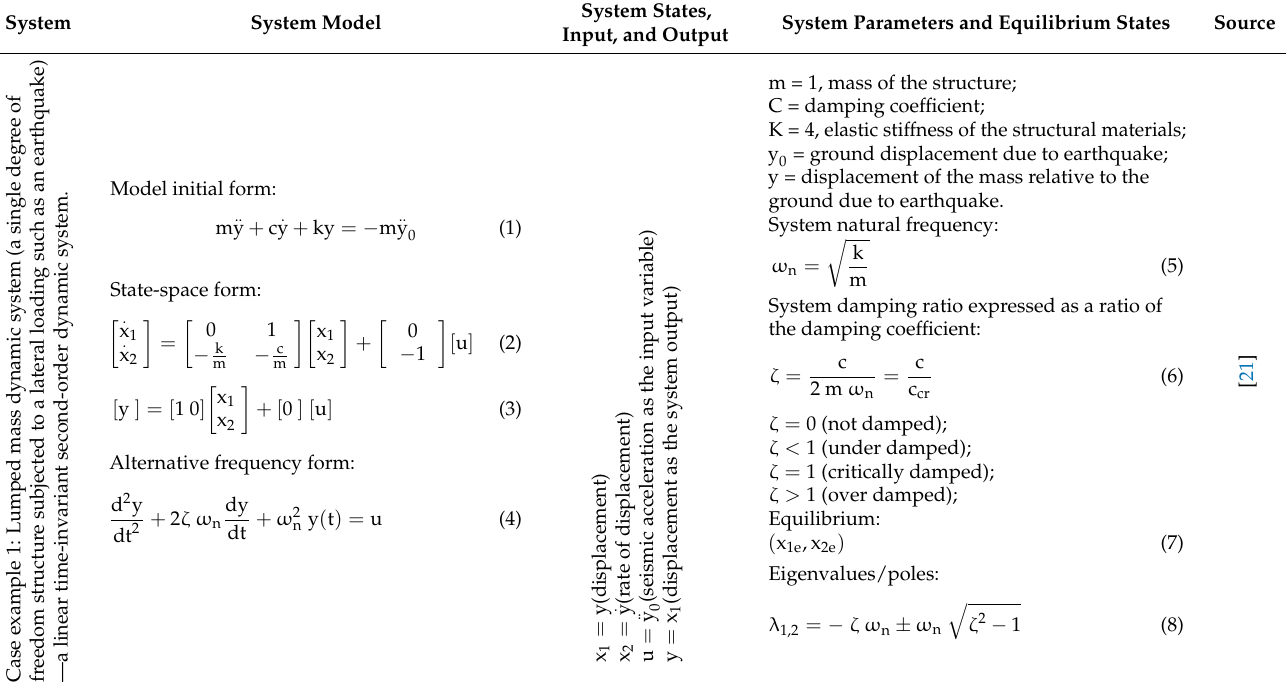
Table 1. Dynamic system case examples for stability and resilience thinking.